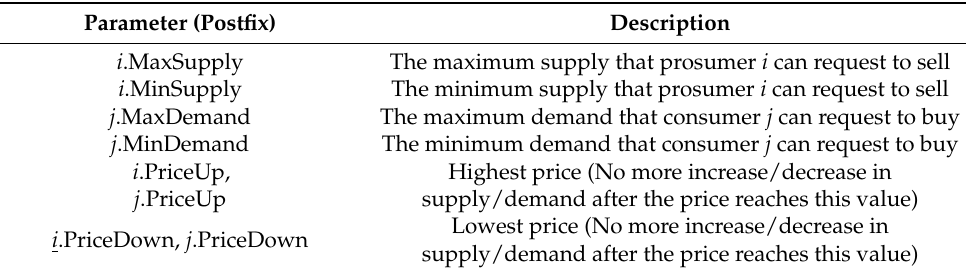
Table 2. Parameters for personas representing prosumers and